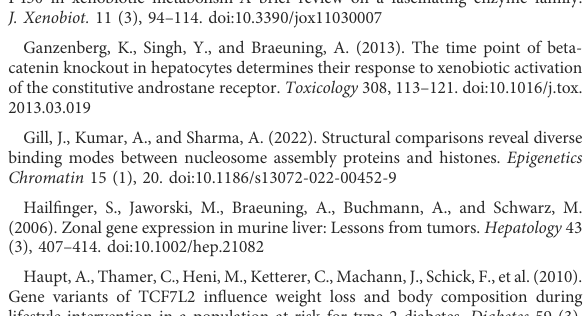
SUPPLEMENTARY FIGURE S1 The pie charts and Venn diagrams for each individual pull down by TSPYL1, 2 and 4 . Pie charts depicting the signaling pathways pulled down by TSPYL1 (A) , TSPYL2 (B) , or TSPYL4 (C) , respectively. (D) A Venn diagram of TSPYLsinteractingsignalingpathwaysforallthreeTSPYLsstudied.TheTSPYL interacting proteins and pathways are listed in a supplementary excel fi le. SUPPLEMENTARY FIGURE S2 TSPYL1 binding to the CYP7A1 promoter region in HepaRG cells was not detected. (A) Four pairs ofprimers coveringthe CYP7A1 promoter region were used for CHIP assays. (B) CHIP assays were performed to test TSPYL1 binding to the CYP7A1 promoter region using HepaRG cells. The binding of TSPYL1 to the CYP7A1 promoter is shown as fold enrichment compared with IgG control. A set of control primers targeted to non- proteinbindingareaswereusedasanegativecontrol.Comparedwiththe negative control, TSPYL1 was not found to bind to the CYP7A1 promoter region in HepaRG cells. SUPPLEMENTARY FIGURE S3 (A,B) Effect of Wnt/ β -catenin signaling on basal CYP expression. For β - catenin knockdown, HepG2 cells were treated with siRNA against β - catenin (C, blue bars). For β -catenin (CTNNB1) activation, HepG2 cells were treated for 24 h with 200 ng/ml Wnt-3a (D, red bars). The levels of the indicated CYPs were measured by PCR. By β -catenin knockdown in HepG2 cells, CYP1B1, CYP2A6 and CYP2B6 were transcriptionally downregulated more than 2-fold, whereas CYP2C9, CYP2C18, CYP3A7, CYP7A1, CYP7B1, and CYP27A1 were upregulated by β -catenin knockdown (A) .Bycontrast,afterWnt-3astimulation,CYP1B1,CYP2A6, and CYP2B6 expression was signi fi cantly upregulated, while the expressionofCYP2C9,CYP2C19,andCYP3A7wasdownregulatedmore than 2-fold (B) . Vehicle controls (0.1% bovine serum albumin and nontargeting control siRNA, respectively) were used. Data represent means±SDofthreetechnicalreplicatesperexperiments.Student t -test were used for statistical analysis. Statistical signi fi cance is indicated by asterisks. *P < 0.05, **P < 0.01, ***P < 0.001, ****P < 0.0001. SUPPLEMENTARY TABLE S1 Summary of mass spectrometric analysis of wnt signaling proteins associated with